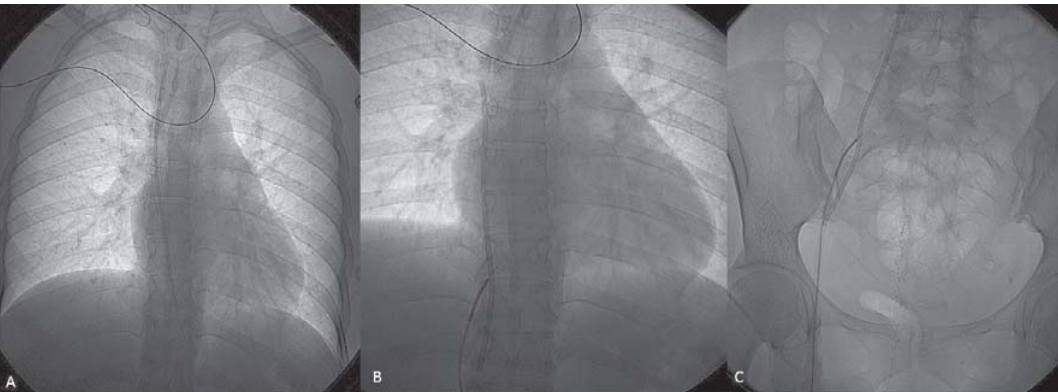
Fig. 3 – A: Extremidade proximal do cateter localizada na veia inominada direita e a extremidade distal localizada na veia cava inferior. B: Captura da extremidade distal do cateter, com laço improvisado (cateter cobra II 5 French e microguia 300cm dobrado). C: Retirada do corpo estranho intravenoso através da veia femoral